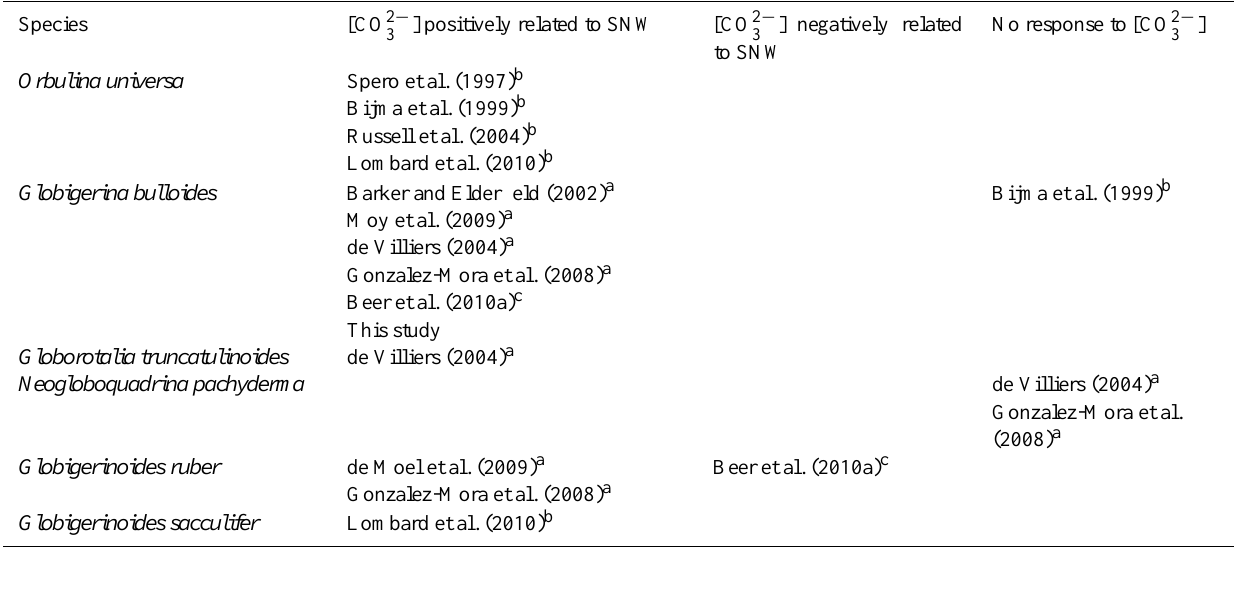
Table 1. Inter and intra-specific diversity in the response of different foraminifera species to [CO 2 − cores (a), laboratory cultures (b), and plankton net samples (c) are shown.